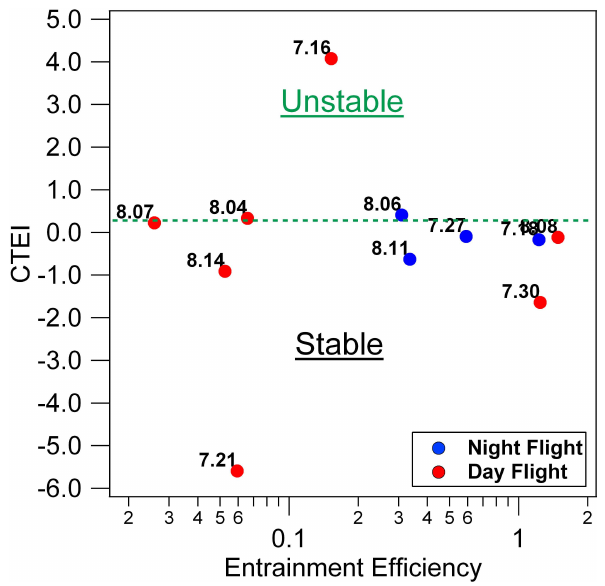
Fig. 14. Scatter plot of the entrainment efficiency η versus the CTEI Deardorff-Randall criterion κ (see Eq. 6). Each point is the average value for the flight, with the corresponding date beside each point, and color denoting day and night flights. The dotted line denotes the κ ∗ = 0 . 23